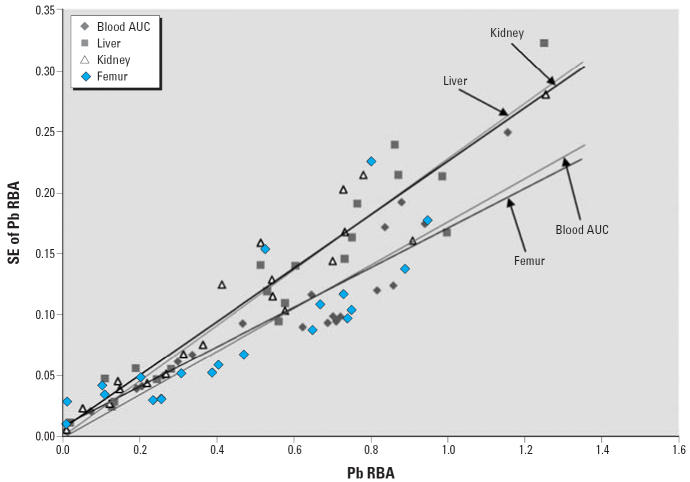
Evaluation of relative precision of measurement end points. Fcrit, critical frequency. For blood AUC, slope = 0.177, intercept = −0.002, and R2 = 0.867; for liver, slope = 0.227, intercept = 0.000, and R2 = 0.916; for kidney, slope = 0.219, intercept = 0.006, and R2 = 0.914; and for femur, slope = 0.162, intercept = 0.008, and R2 = 0.732. The results of the comparison of regression lines showed
the following: F = 0.638; Fcrit(0.05) = 2.227; and p = 0.699.